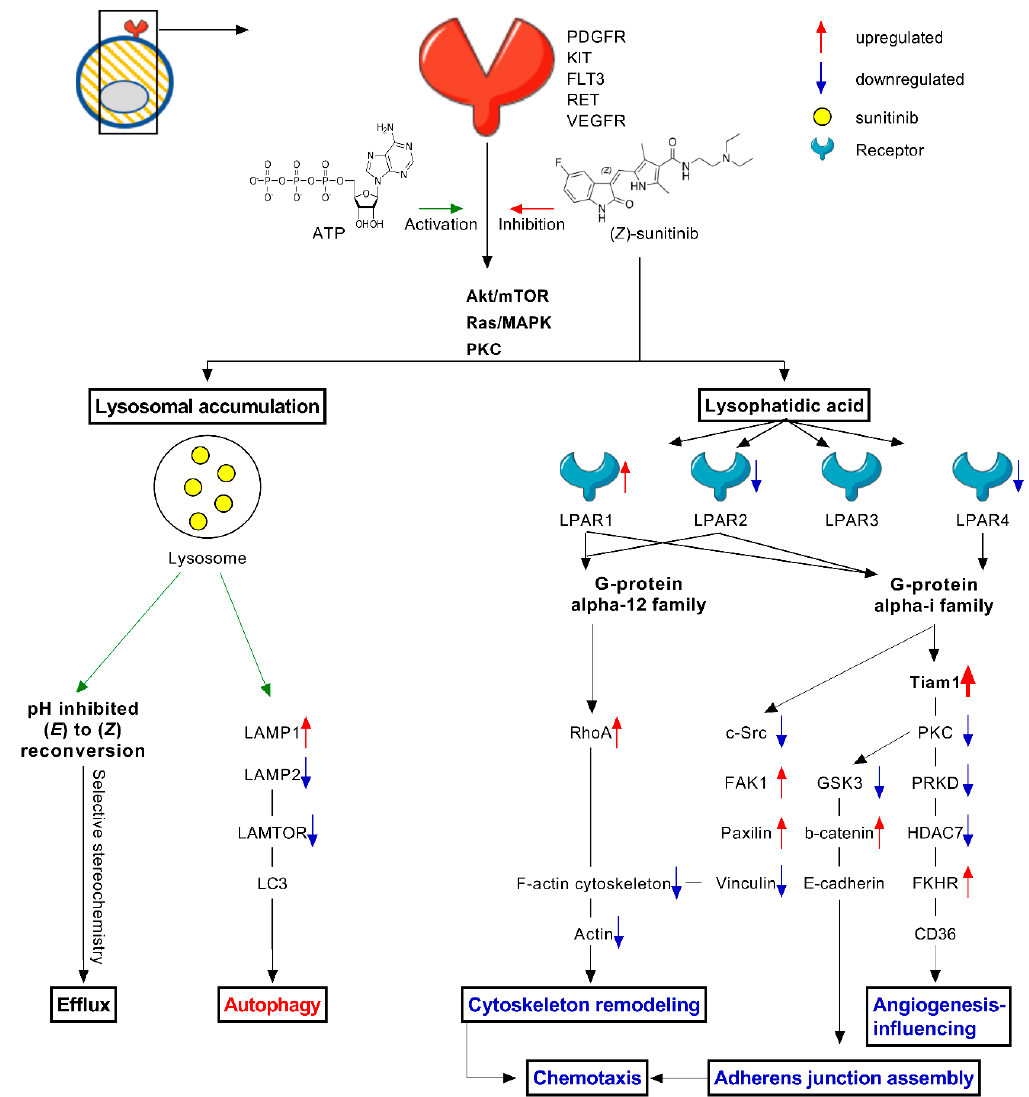
Figure 3. Cellular changes induced through chronic treatment with sunitinib resulting in sunitinib resistance. Schematic representation of induced cellular changes in response to sunitinib treatment, mainly focusing on autophagy, chemotaxis and stereoisomerisation after lysosomal accumulation. Sunitinib inhibits the signal transduction via Akt/mTOR, Ras/MAPK and PKC through binding to the ATP-binding site of numerous cell membrane receptors, i.e., PDGFR, c-KIT, FLT-3, RET, VEGFR. Lysosomal accumulation: Lysosomes store sunitinib, where the acidic pH inhibits the reconversion from ( E ) to ( Z ). Cells might have intrinsic selectivity to stereoisomers, which could be linked to efflux. Lysosomal storage further induces autophagy by dysregulating autophagy-related proteins, i.e., LAMP, LAMTOR, MAPK and MTOR activator and LC3. Lysophatidic acid: Sunitinib treatment induces the production of lysophatidic acid, which binds to lysophosphatidic acid receptors (LAPR) that are linked to G-protein signaling. Dependent on the subsequent signaling pathway, cellular functions, i.e., cytoskeleton remodeling, adherens junction assembly, angiogenesis-influencing proteins and chemotaxis, will be downregulated. Legend: ATP = adenosine triphosphate; CD36 = integral membrane protein; c-Src = protein kinase; FAK = focal adhesion kinase; FKHR = Forkhead box protein O1 (FOXO1); FLT3 = fms like tyrosine kinase 3; GSK3 = serine/threonine protein kinase (Glycogen synthase kinase 3); HDAC = histone deacetylase; KIT = tyrosine kinase; LAMP = lysosome associated membrane protein; LAMTOR = endosomal/lysosomal adaptor and mitogen activated protein kinase; LAPR = lysophosphatidic acid receptor; MAPK = mitogen activated protein kinase; PDGFR = platelet derived growth factor receptor; LC3 = light chain 3; PKC = protein kinase C; PRKD = serine/threonine protein kinase; RET = tyrosine protein kinase receptor; RhoA = Ras homolog family member A; Tiam = T-lymphoma invasion and metastasis-inducing protein 1; VEGFR = vascular endothelial